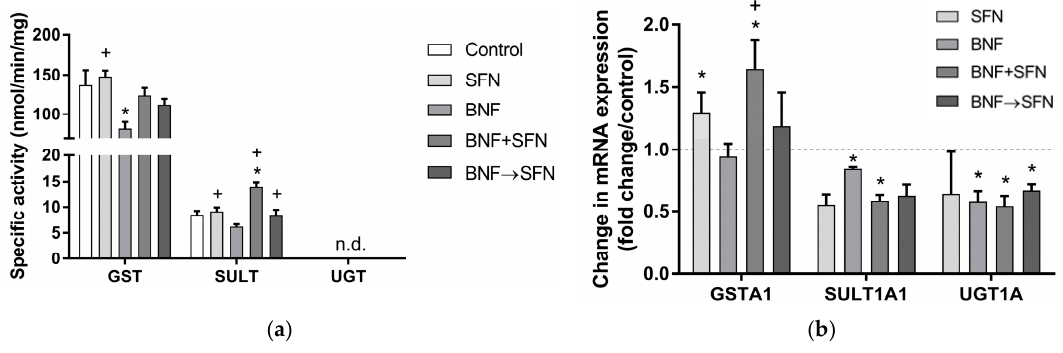
Figure 3. Effect of sulforaphane (10 μ M) on the activity ( a ) and mRNA expression ( b ) of conjugation enzymes in rat hepatocytes treated or non-treated with β -naphthoflavone (10 μ M). Primary rat hepatocytes were incubated at 37 °C for 24 h. Specific enzyme activities of glutathione S-transferases (GST; cytosol), sulfotransferases (SULT; cytosol) and UDP-glucuronosyl transferases (UGT; microsomes) were determined as nmol of formed product (GST, SULT) or consumed substrate (UGT) per min per mg of protein. The data are expressed as the mean ± SD ( n = 3). The mRNA or specific activity significantly altered ( p ≤ 0.01) compared to control (*) or β -naphthoflavone (+). BNF β -naphthoflavone; SFN sulforaphane; BNF + SFN co-administration of BNF + SFN; BNF → SFN 6-h BNF pre-treatment followed by SFN addition; n.d. not determined.